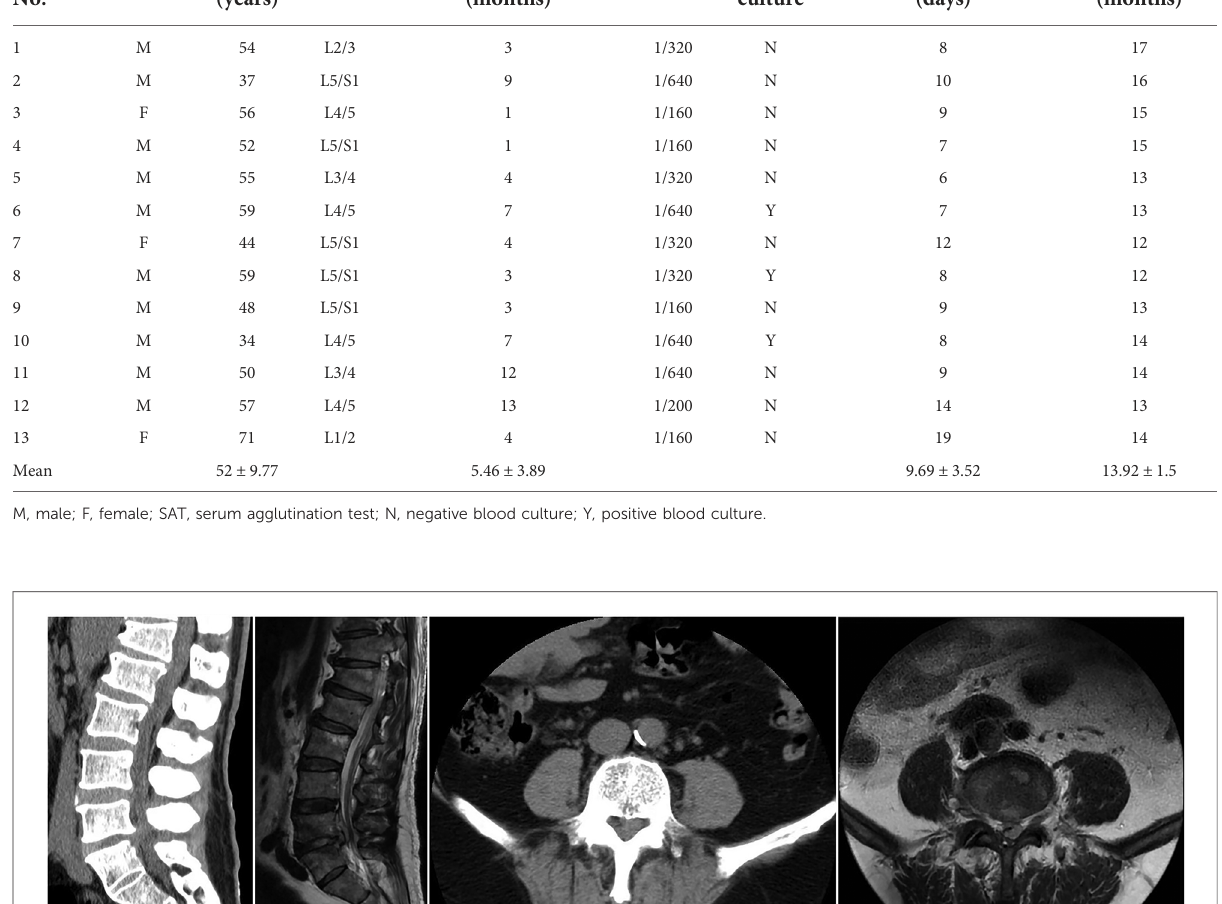
TABLE 1 Demographic characteristic of all patients. Case